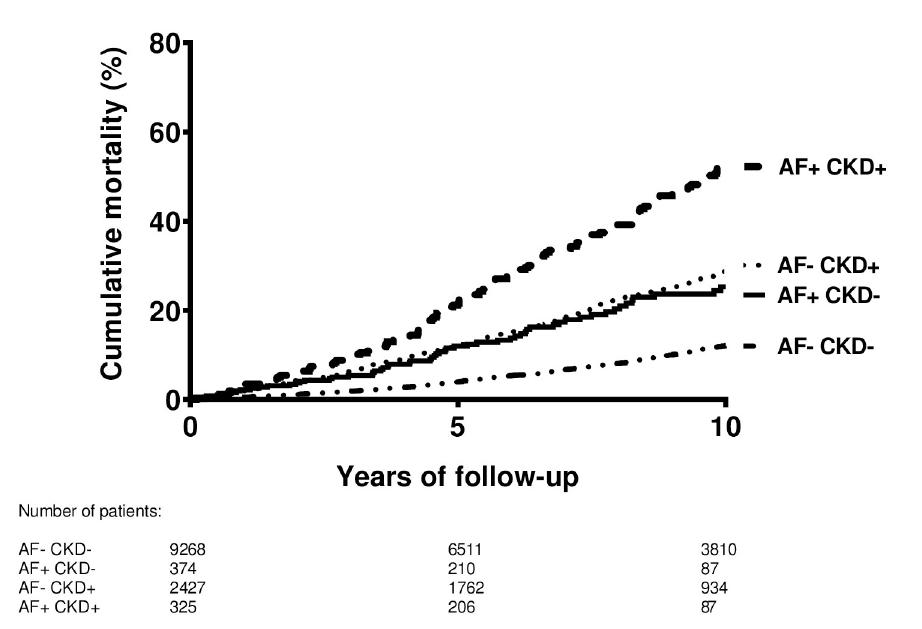
Fig 2. Kaplan-Meier survival curve for ten year